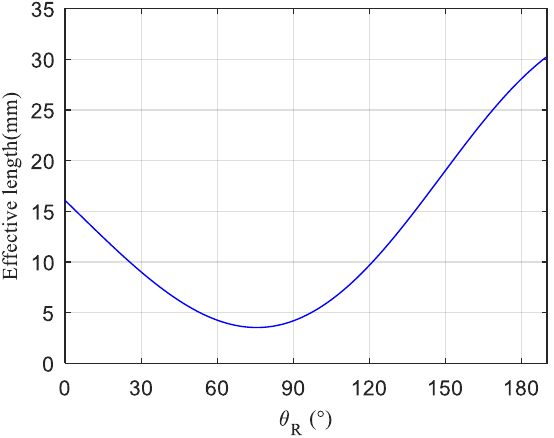
Figure 8. The relationship between effective length and stiffness motor angle.